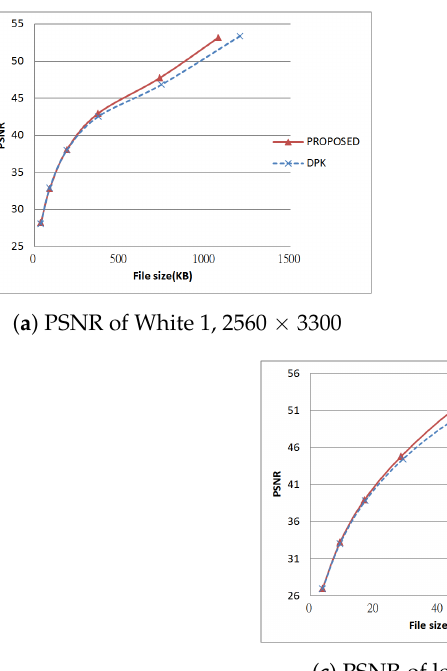
Figure 27. Visual comparison of the logo image (partial, 150 × 150).